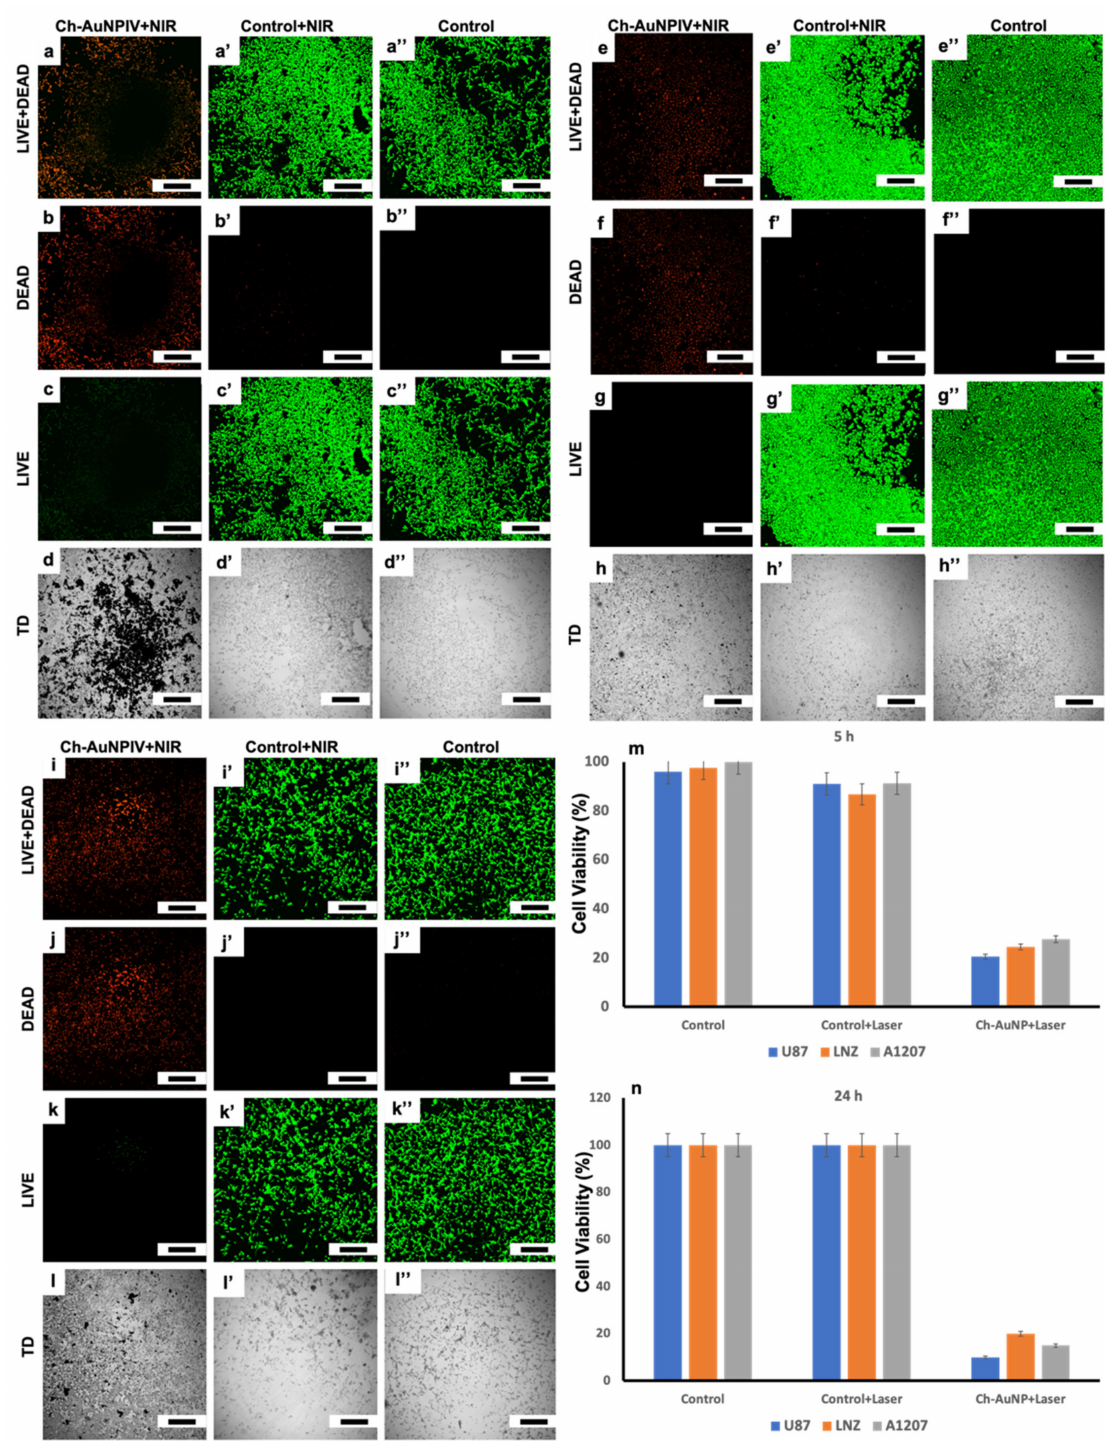
Figure 8. Post-NIR PTT observations revealed that most of the cells (Ch-AuNPs treated) were dead ( b , f , j ) with very few cells remaining metabolically active ( c , g , k ) Furthermore, cell viability assessment revealed that the cancer cells continued to die without any traces of relapse ( m , n ).